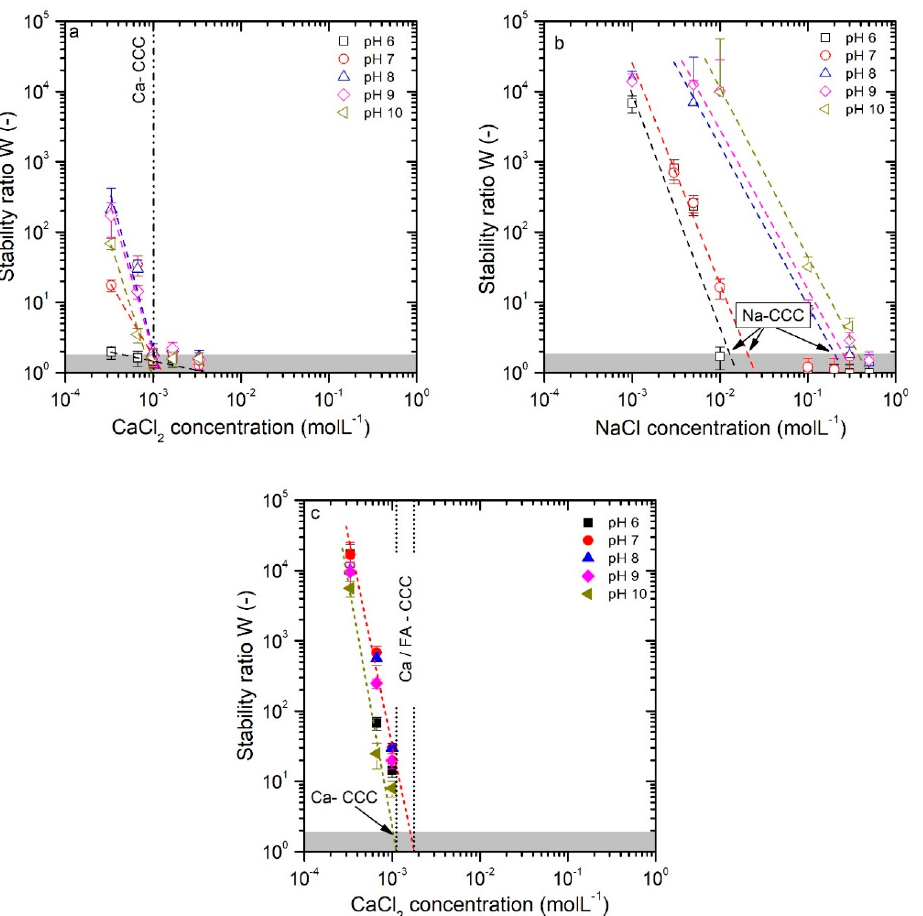
Figure 2. Stability ratio W of FEBEX bentonite colloids is plotted against the electrolyte concentration for CaCl 2 in ( a ) and ( c ) as well as NaCl in ( b ). The critical coagulation concentration (CCC) was determined, in which W transitions from higher values to 1. The grey shaded area at the bottom of each graph is considered to show values for the CCC due to errors in stability ratio measurements. The influence of addition of 1 mg · L − 1 DOC (GoHy-573 FA) on W for all measured concentrations is depicted in graph ( c ). While using NaCl as the background electrolyte, the calculated W values are plotted against the concentration in Figure 2b. As expected for a 1:1 background electrolyte, in the NaCl systems, the concentrations required to induce FEBEX bentonite coagulation are much higher than using CaCl 2 as the background electrolyte, following, in general, the trend predicted by the Schultz–Hardy rule [25]. However, the concentrations are found to be not inversely proportional to the sixth power of the cation valence. In contrast to the Ca-CCC, the Na-CCC is clearly dependent on the pH value of the system with an Na-CCC of 15 ± 5 mmol L − 1 at pH 6, 20 ± 5 mmol L − 1 at pH 7, 200 ± 50 mmol L − 1 at pH 8, 250 ± 50 mmol L − 1 at pH 9, and 350 ± 100 mmol L − 1 at pH 10, respectively. The Na-CCC values determined for the NaCl system are plotted as a function of the pH value in Figure 3b. The determined Na-CCC values for pH 6 and pH 7 are in good agreement with published Na-CCC data for SWy-1 and the beidellite from Hetzel and Doner [52] and Lagaly and Ziesmer [55] for pH 6.5, and Chheda et al. [56] for pH 6.8. Tombácz and Szekeres [59], however, determined Na-CCC values at pH 6 for Wyoming montmorillonite SWy-1 and SWy-2 of 52 mmol L − 1 —considerably higher than the Na-CCC values observed in this study for FEBEX bentonite. Sellin et al. [54] and Missana et al. [22] determined an Na-CCC below 10 mmol L − 1 at pH 6.7 and pH 7, respectively.